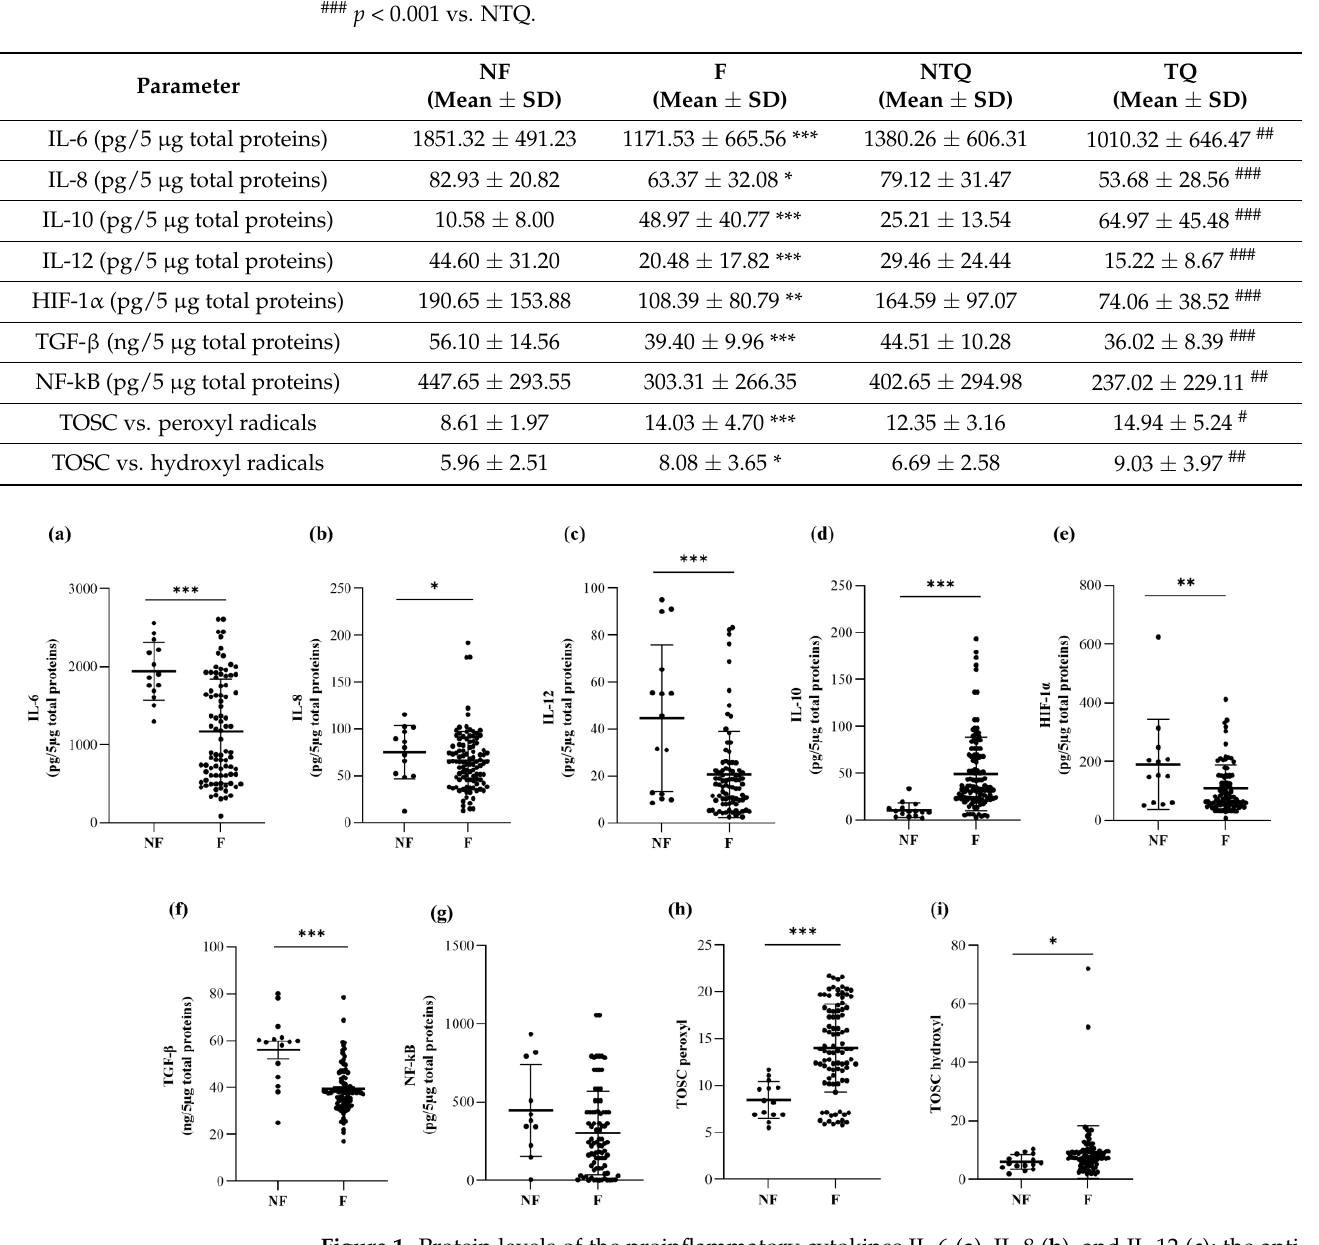
Figure 1. Protein levels of the proinflammatory cytokines IL-6 ( a ), IL-8 ( b ), and IL-12 ( c ); the anti- inflammatory cytokine IL-10 ( d ); the pro-inflammatory factors HIF-1 α ( e ), TGF- β ( f ), and NF-kB ( g ); and TOSC values against peroxyl ( h ) and hydroxyl ( i ) radicals in follicular fluid (FF) samples from unfertilized (NF) and fertilized oocytes (F). The interleukins and pro-inflammatory factors were measured with commercial ELISA kits, while the antioxidant activity of FF samples was measured by chromatographic analysis. The data are reported as the mean values ± SD. Statistical analysis was performed by unpaired t-tests: * p < 0.05, ** p < 0.01, *** p < 0.001 (TQ vs. NTQ).